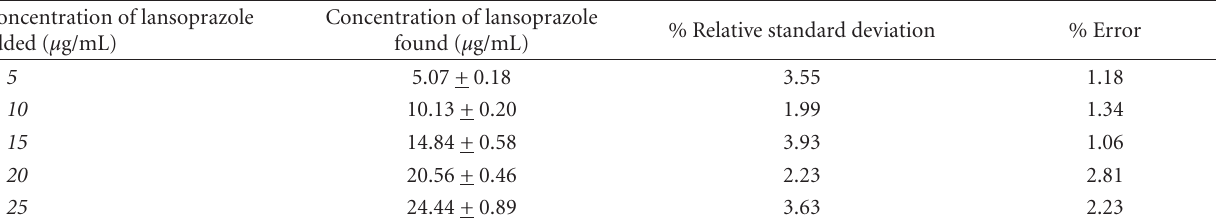
Table 2: Interday precision over four days (% relative standard deviation (% RSD)) and accuracy (% error) of the LC-MS/MS assay for quantification of lansoprazole ( n = 20 for each concentration). Concentration of